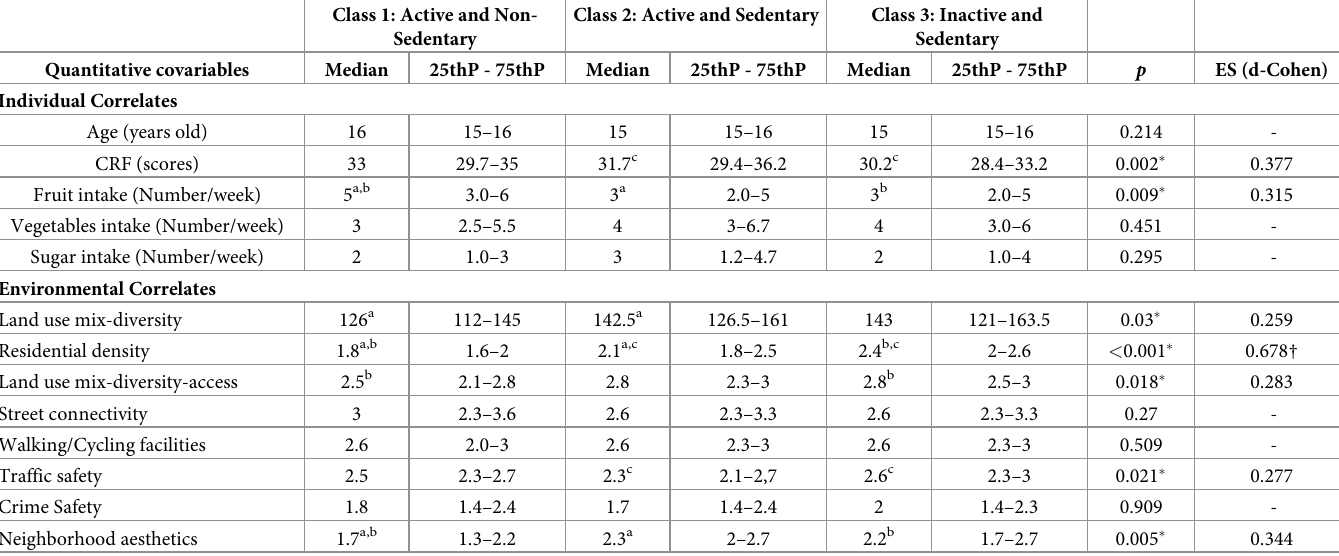
Table 4. Continuous variables variability related to individual, family, and environmental